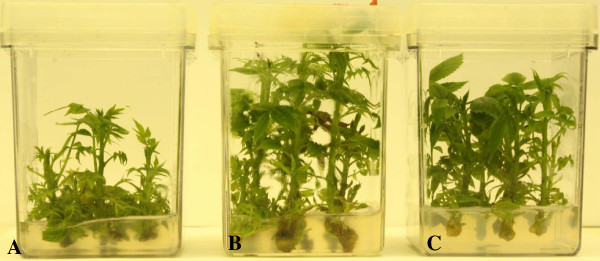
Morphology of transformed walnut shoots. A)In vitro-grown plants of co-transformed 33-3-1. B) Untransformed control. Co-transformed plants had stunted growth, shorter internode lengths, and darker green, smaller, and more wrinkled leaves than the control. C)In vitro-grown plants of single-vector transformed line 29-3-1 were phenotypically similar to the untransformed control.